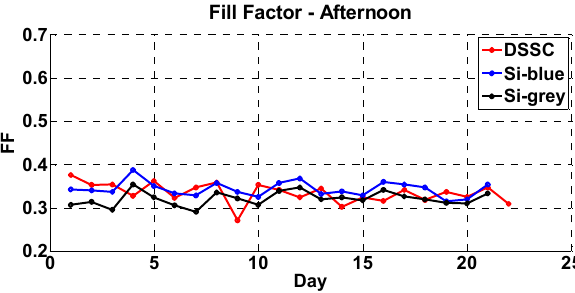
Figure 24. Afternoon FF trends of the three generation systems.